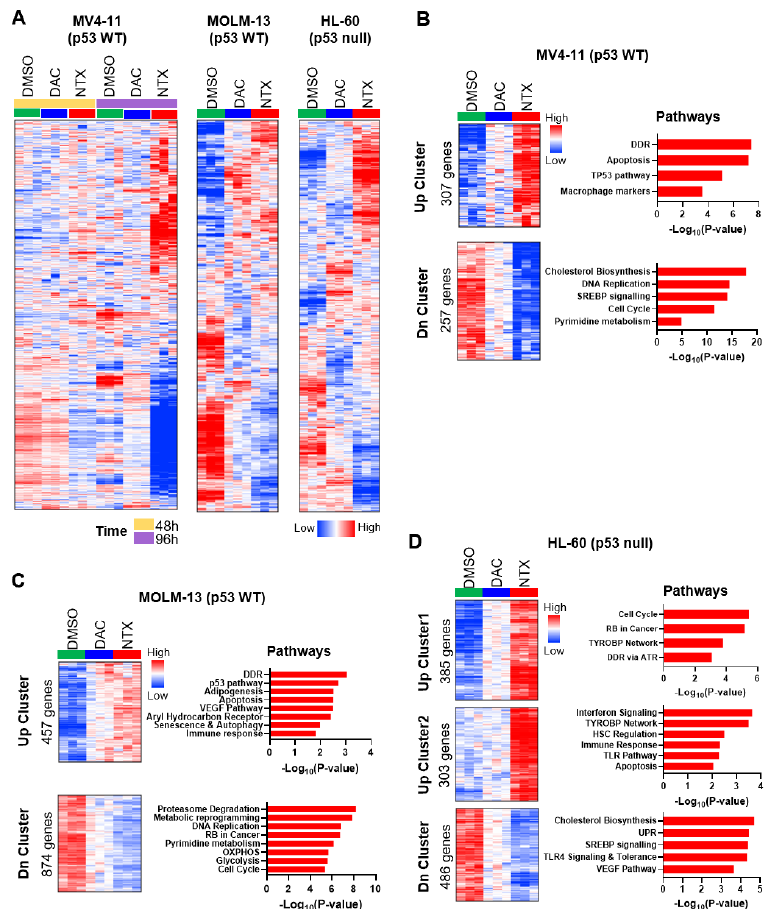
Figure 4. Transcriptome analysis revealed the MoA of NTX-301. ( A ), Heatmaps displaying global changes in the transcriptomes of MV4-11, MOLM-13, and HL-60 cells after treatment with DMSO, NTX-301, or DAC (60 nM for MV4-11, 30 nM for HL-60, and 15 nM for MOLM-13). ( B – D ), Heatmaps showing gene sets that were more strongly up- (Up Cluster) or downregulated (Dn Cluster) by NTX- 301 than by DAC and bar plots showing biological pathways associated with each gene set in MV4-11 ( B ), MOLM-13 ( C ), and HL-60 ( D ) cells. ( B – D ) are updated figures of Supplementary Figure S5B, previously published in